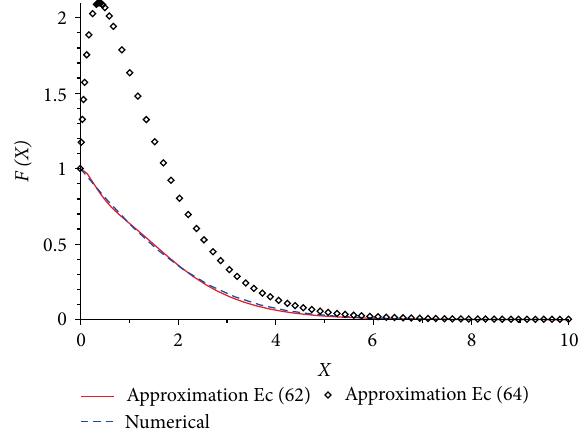
Figure 5: Comparison between numerical solution of (33) and approximations (62) and (64) for 휀 = 1.5.